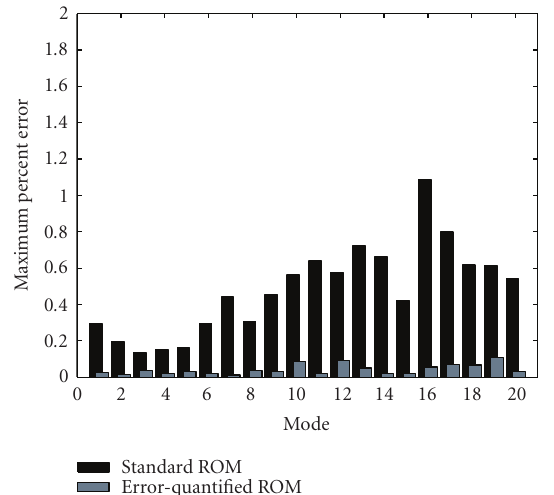
Figure 9: Modal force prediction comparison (Mode